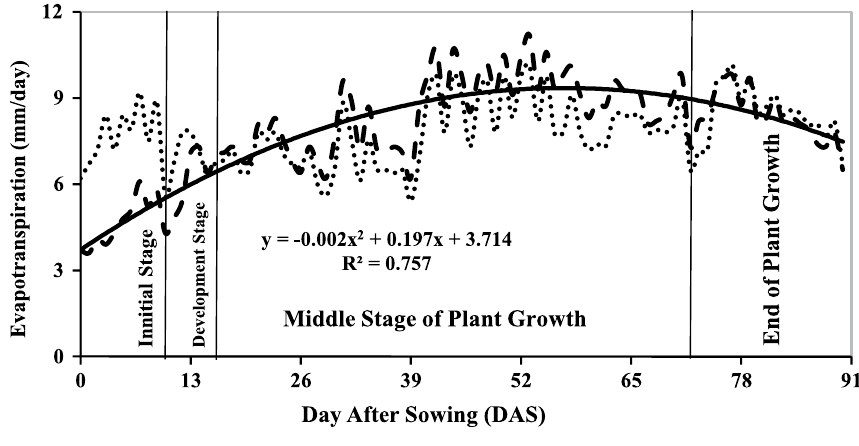
Fig. 5 The trend of changes in the reference and plant evapo- transpiration during the